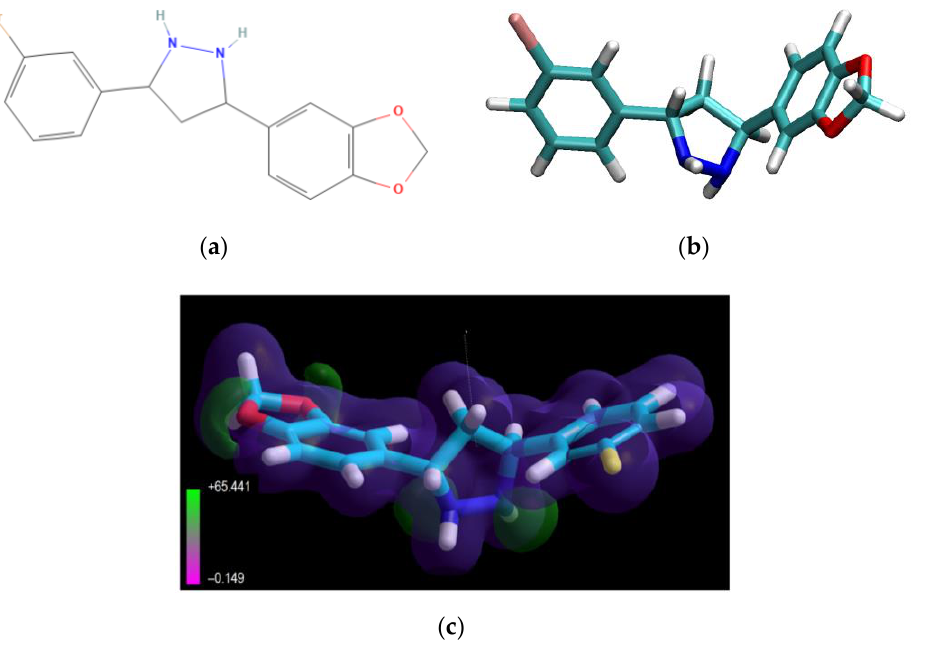
Figure 12. Structural formulas 2D ( a ) and 3D ( b ) of the Anle138b isomer; ( c ) electrostatic potential distribution for the Anle138b isomer molecule (according to the PM3 calculation, MOPAC 2021). The value of the gas-phase heat of formation of the Anle138b isomer molecule is positive and amounts to 16.6 kcal/mol, which is typical for aromatic compounds (Figure 12). The Anle138b isomer ligand was detected after two consecutive screening rounds. Of note, the ligand does not interact with the A α Syn monomer, but binds to the hydrophobic pocket A α Syn aggregates [16]. Anle138b isomer specifically inhibits the formation of A α Syn in oligomers in vitro and in the human cell line, HEK293 [50]. The physical and chemical properties of Anle138b isomer are outlined in Table